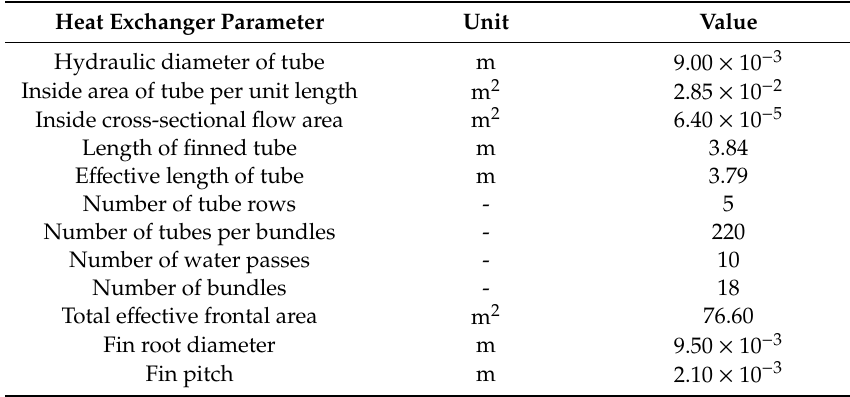
Table 4. The detailed data for the heat exchanger.